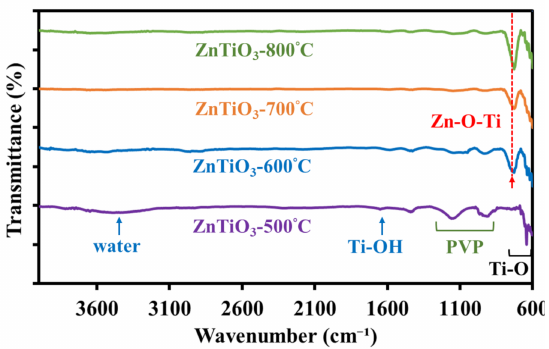
Figure 3. FTIR spectra of various ZnTiO 3 calcinated at 500~800 ◦ C.